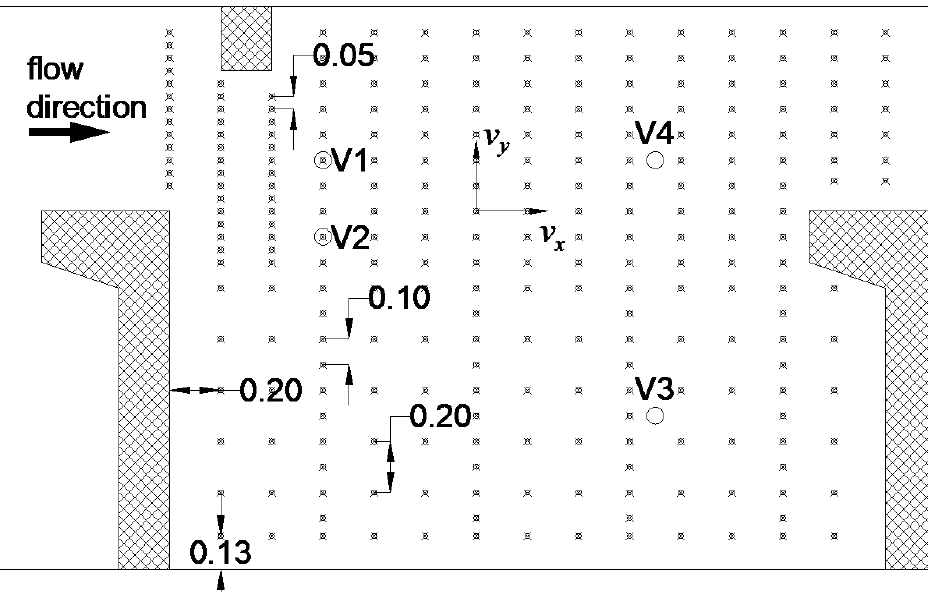
Figure 1. Locations of flow velocity measurements by Bombaˇc et al., (2015) [12].